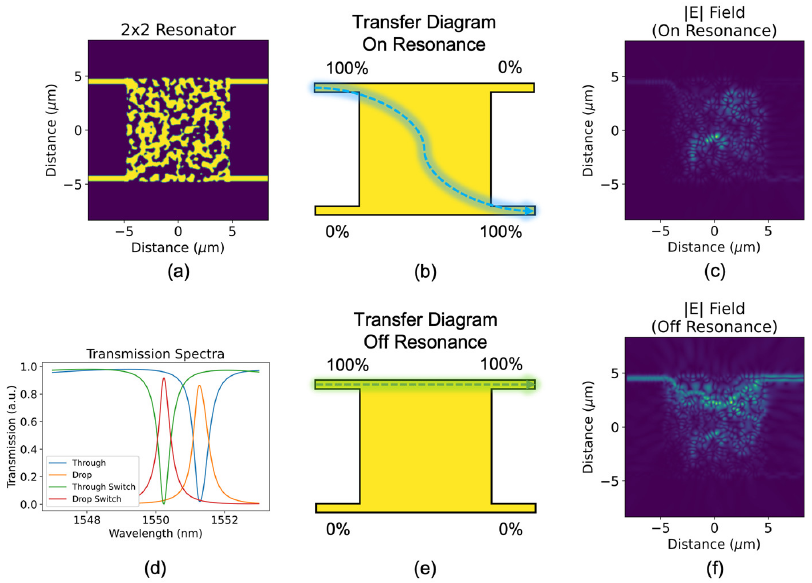
Figure 4. ( a ) Topologically optimized all-forward add–drop resonator, ( d ) its transmission spec- trum, and its transfer diagrams for the following initial conditions: ( b ) through-port output (off res- onance), ( e ) drop-port output (on resonance). Top-view optical field profiles of ( b , e ) are shown in ( c , f ),